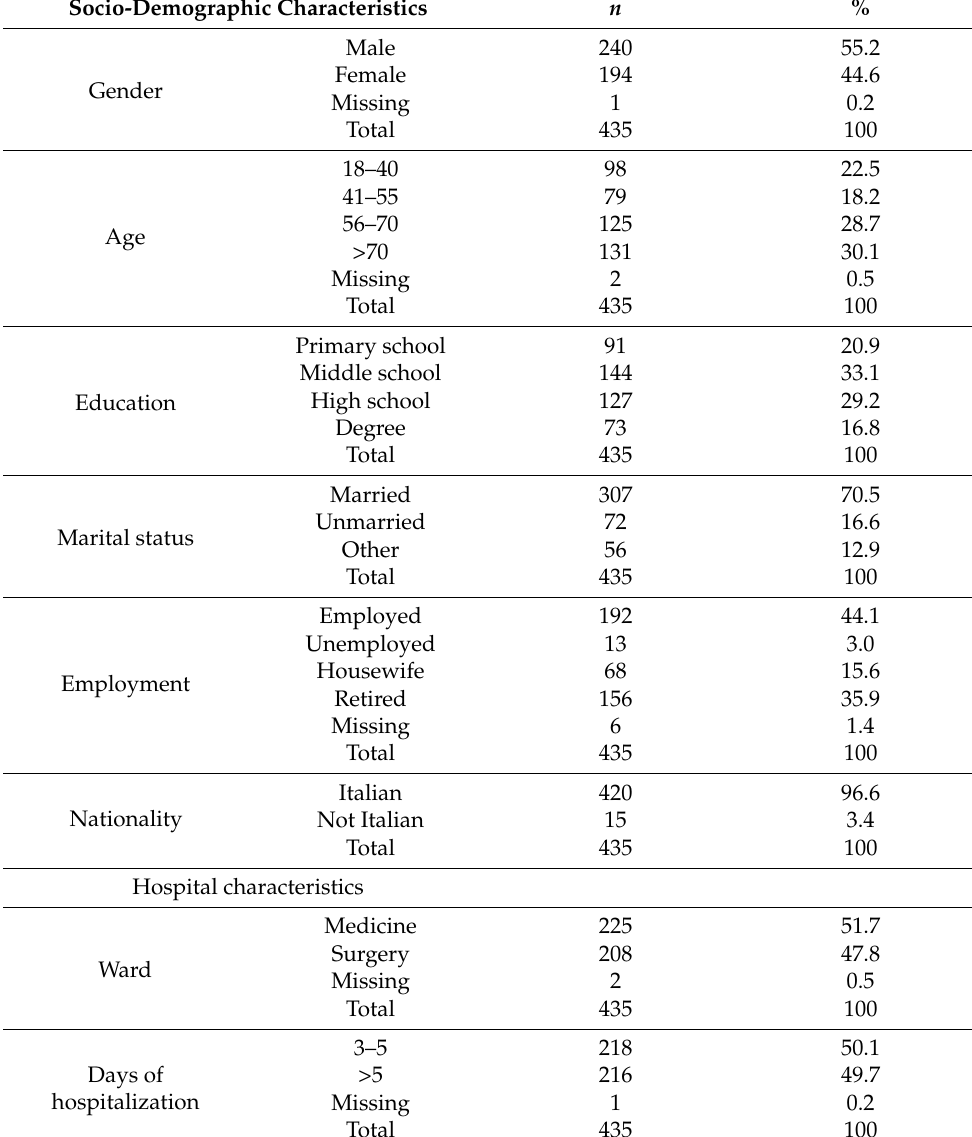
Table 1. Socio-demographic and hospital